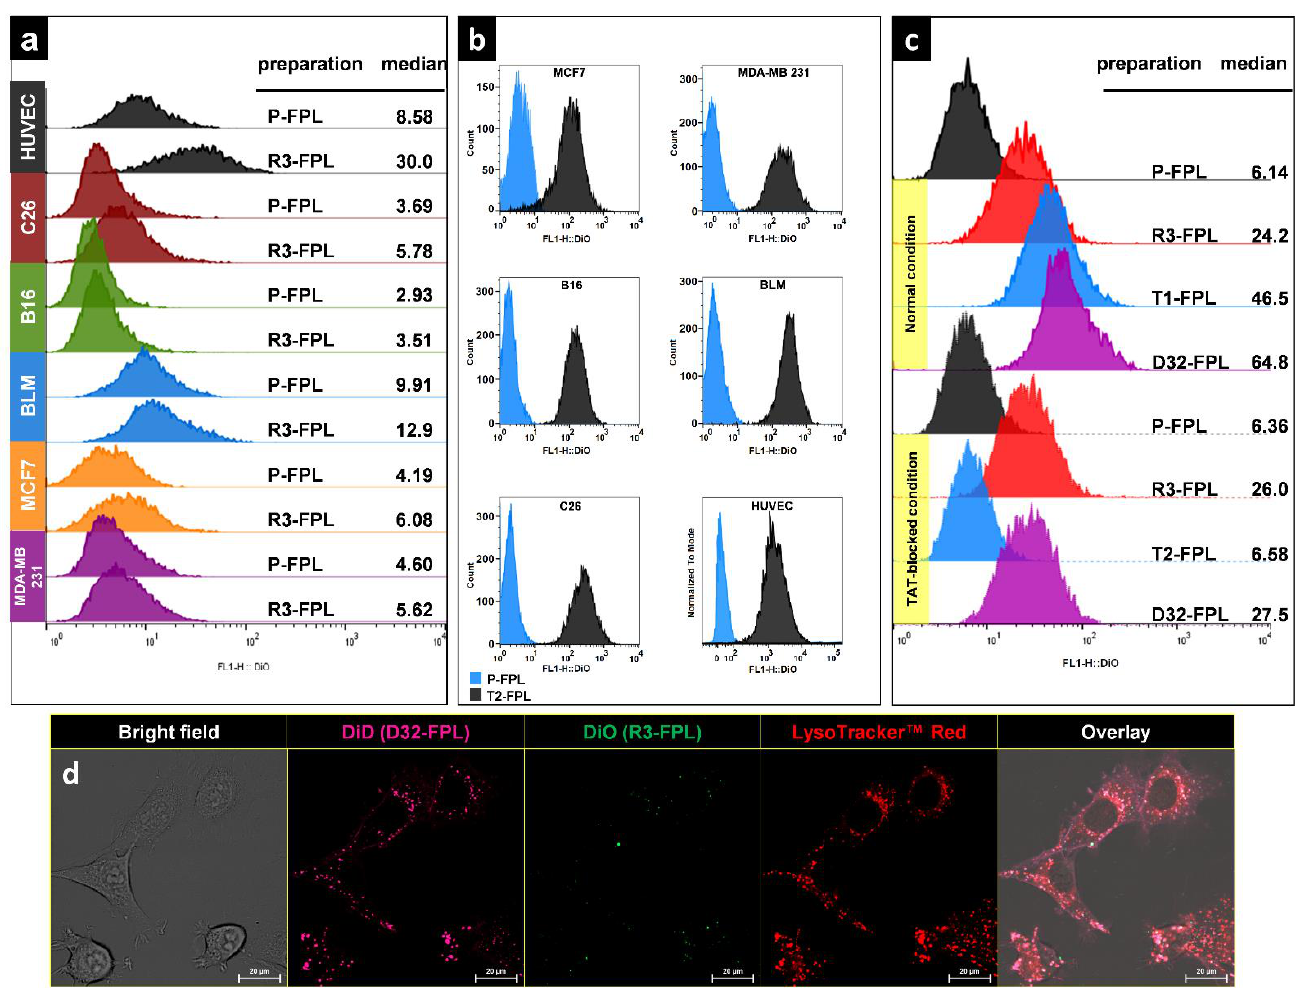
Figure 3. In vitro cellular association of peptide-modified liposomes. ( a ) represents the flow cytometry analysis of different cells exposed to either RGD-modified liposomes (R3-FPL) or plain liposomes (P-FPL). ( b ) represents the flow cytometry analysis of different cells exposed to either TAT-modified liposomes (T2-FPL) or P-FPL. ( c ) represents the cellular association of P-FPL, R3-FPL, T2-FPL, and dual-modified liposomes (D32-FPL) with HUVEC cells in normal and TAT-blocked conditions. ( d ) depicts the confocal live cell imaging of the cellular association of DiO-labeled R3-FPL and DiD-labeled D32-FPL concomitantly incubated with C26 cells, which were preincubated with LysoTracker Red to stain acidified organelles. In all studies, cells (105/ well) were exposed to 100 of nmol phospholipid/500 µL of each preparation, incubated for 3 h at 37 °C, washed, and analyzed. Scale bar: 20 μm.